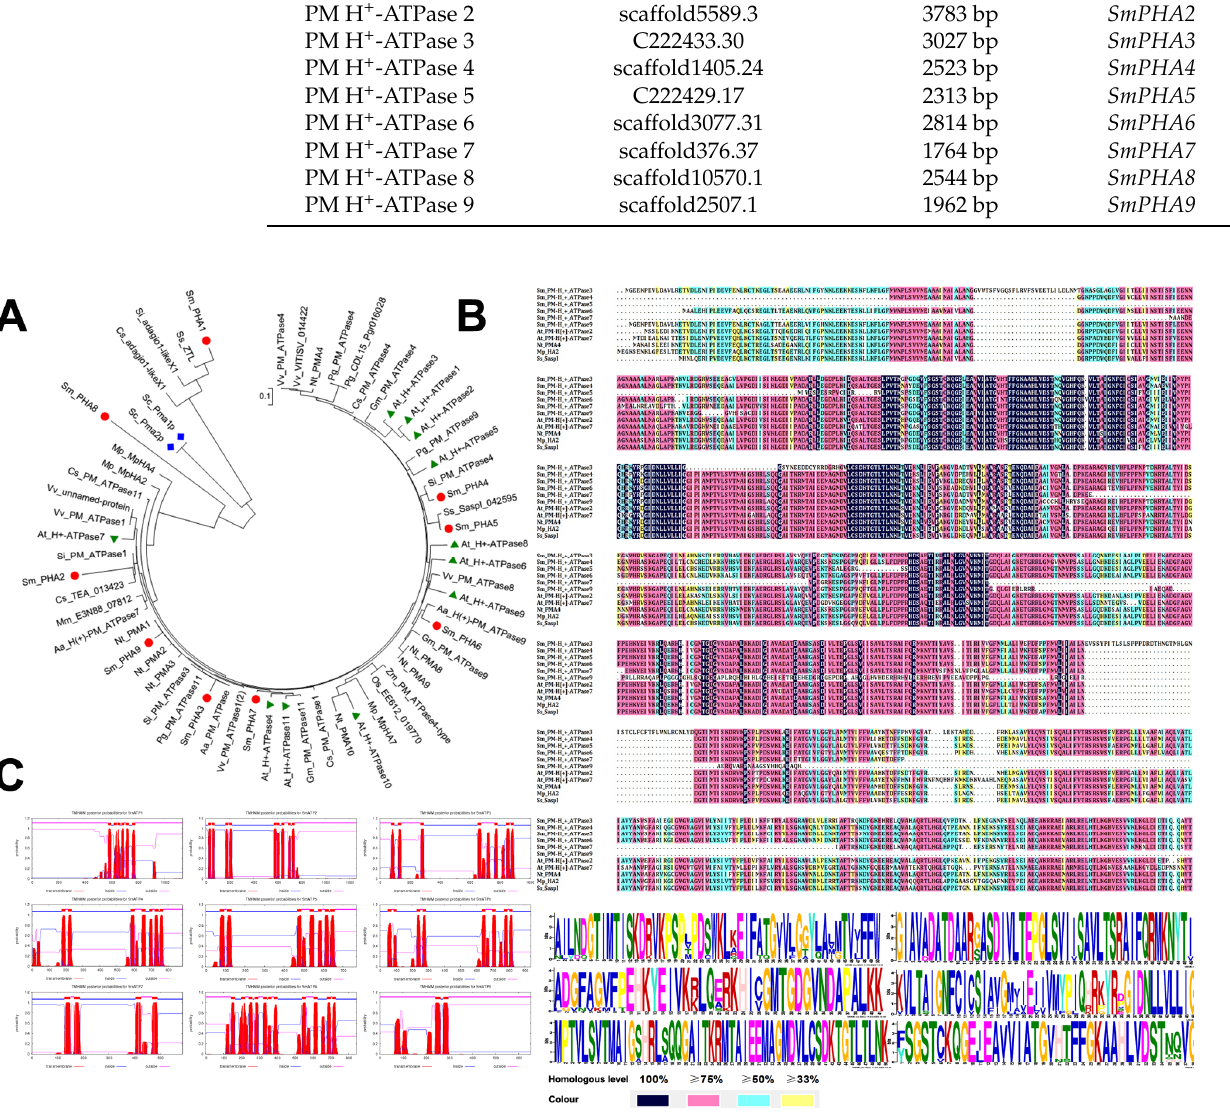
Figure 1. ( A ) Phylogenetic tree showing the relationship between SmPHAs and other PM H + -ATPase genes. Phylogenetic tree was constructed by the neighbor-joining methods in MEGA7.0 software based on amino acid sequence alignment and demonstrated the relationship of the PM H + -ATPase genes from S. miltiorrhiza (Sm), Arabidopsis thaliana (At), Nicotiana tabacum L. (Nt), Saccharomyces cerevisiae (Sc), Vitis vinifera (Vv), Oryza sativa (Os), Zea mays (Zm), Marchantia polymorpha (Mp), Salvia splendens (Ss), Sesamum indicum (Si), Artemisia annua (Aa), Punica granatum (Pg), Glycine max (Gm), Mikania micrantha (Mm), and Camellia sinensis (Cs). The red five-pointed stars, black circles, blue squares, and green triangles indicate S. miltiorrhiza , Arabidopsis thaliana , Saccharomyces cerevisiae , and Marchantia polymorpha , respectively. ( B ) Multiple alignment of SmPHAs with related PM H+-ATPase proteins from other plant species. Protein sequence alignment of PM H+-ATPase proteins were from S. miltiorrhiza , Arabidopsis thaliana , Nicotiana tabacum L., Salvia splendens , and Marchantia polymorpha . Black boxes indicate identical residues; pink boxes, blue boxes, and yellow boxes successively indicate identical residues for at least 75%, 50%, and 33%. ( C ) Transmembrane structure prediction of PM H + -ATPase family in S. miltiorrhiza . The transmembrane structures were predicted by TMHMM Server v.2.0 software (http://www.cbs.dtu.dk/services/TMHMM/ (accessed on 3 March